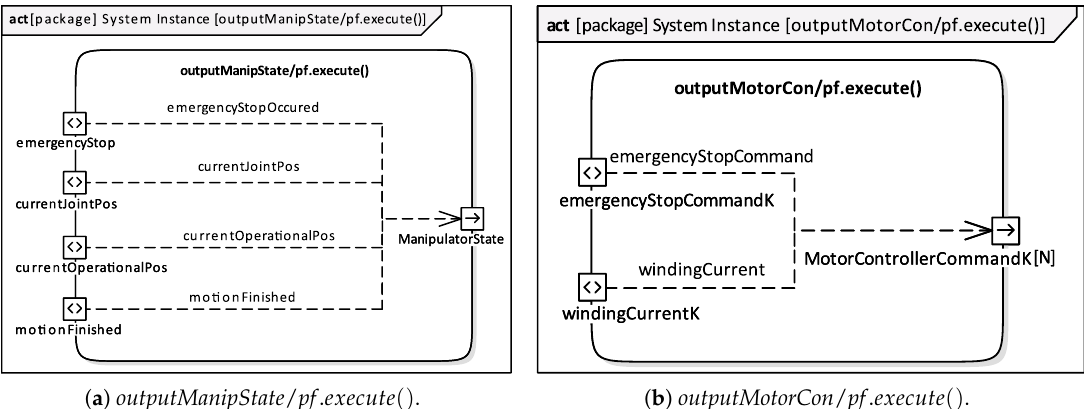
( a ) outputManipState / pf . execute () . Figure 14. manip / a . cs . pf . execute () —operations